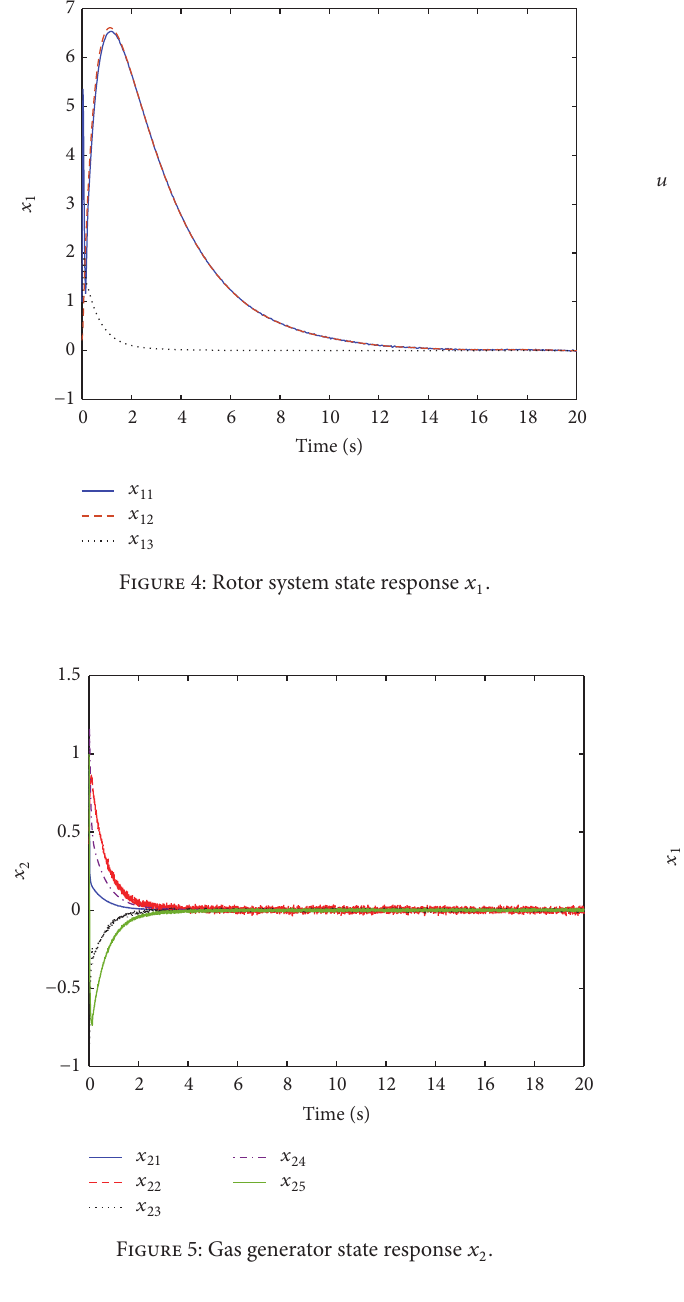
Figure 7: Rotor system state 𝑥 1 under different 𝛼